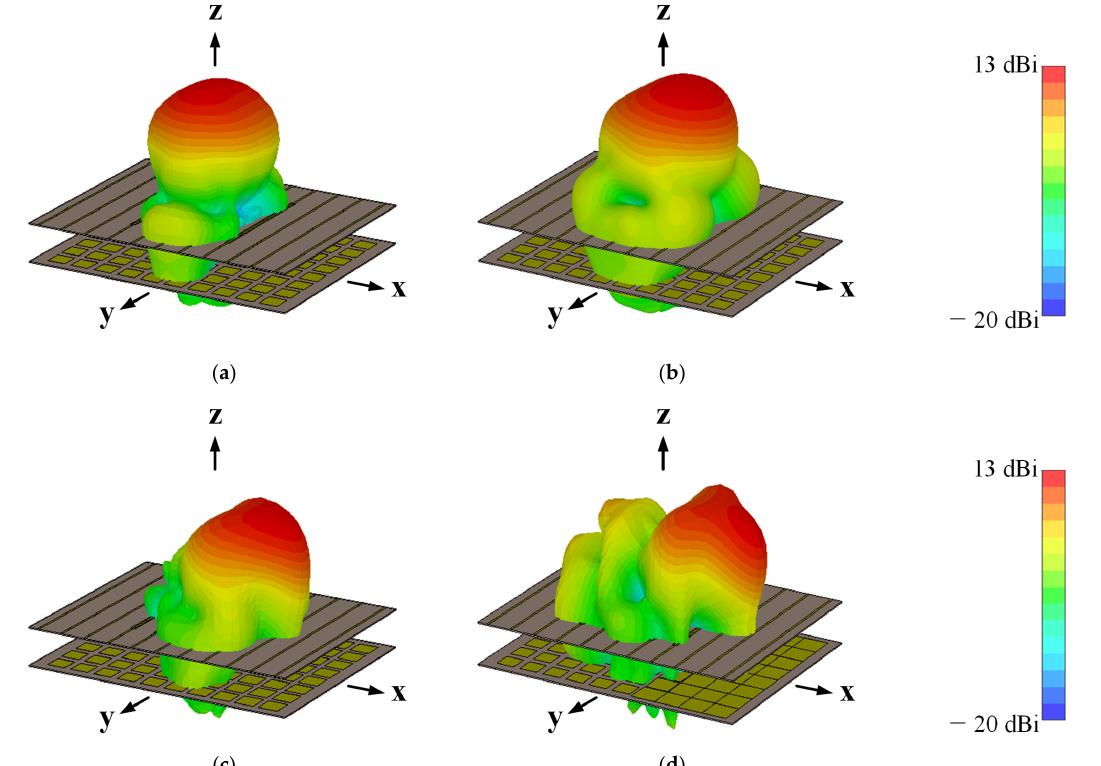
Figure 11. Simulated 3D radiation patterns for each scanned beam at the designed frequency. All target directions are on the xz- plane ( ϕ = 0°): ( a ) θ t = 0°, ( b ) θ t = 15°, ( c ) θ t = 30°, and ( d ) θ t = 45°.